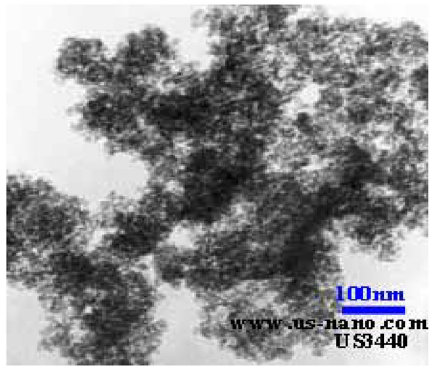
Figure 4. SEM analysis of nanoparticles used in experiments.